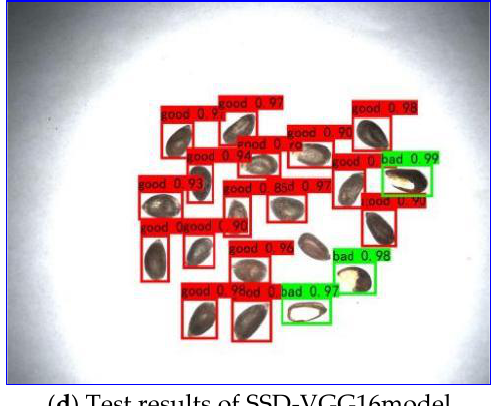
Figure 13. Detection of different models.